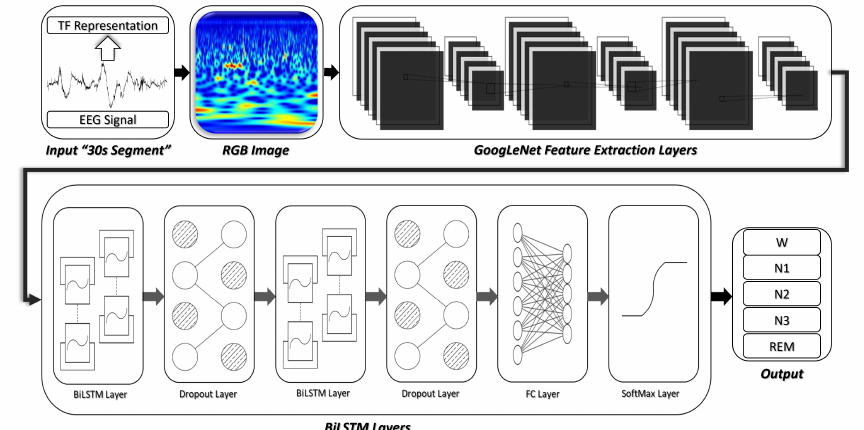
Figure 3. Deep CNN-RNN transfer learning based approach for automatic scoring of sleep